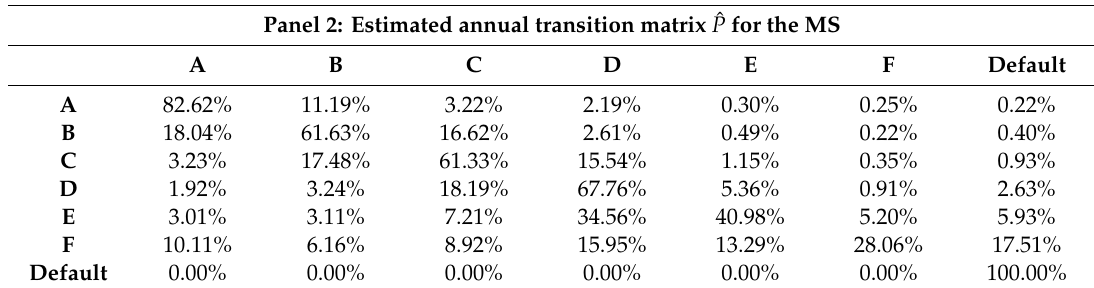
Panel 2: Estimated annual transition matrix ˆ P for the